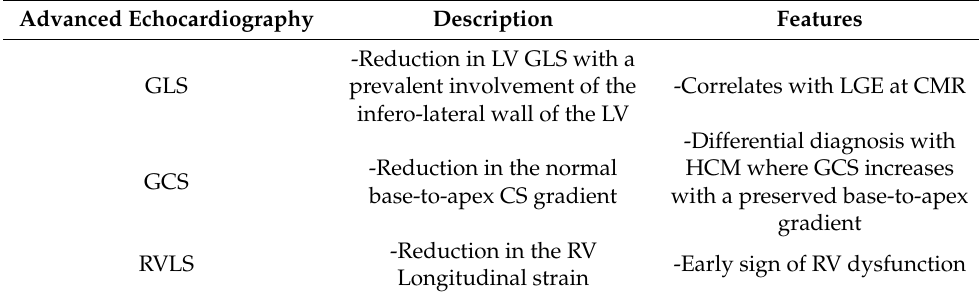
Table 2. Advanced echocardiography in AFD